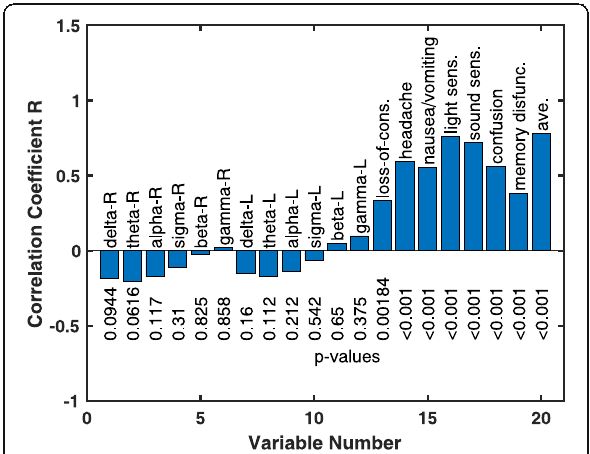
Fig. 1 The correlation R coefficients and corresponding p values are obtained by comparing each observational variable (data matrix column) with the class vector. The EEG variables are labeled by the conventional frequency band names with R and L indicating the right and left